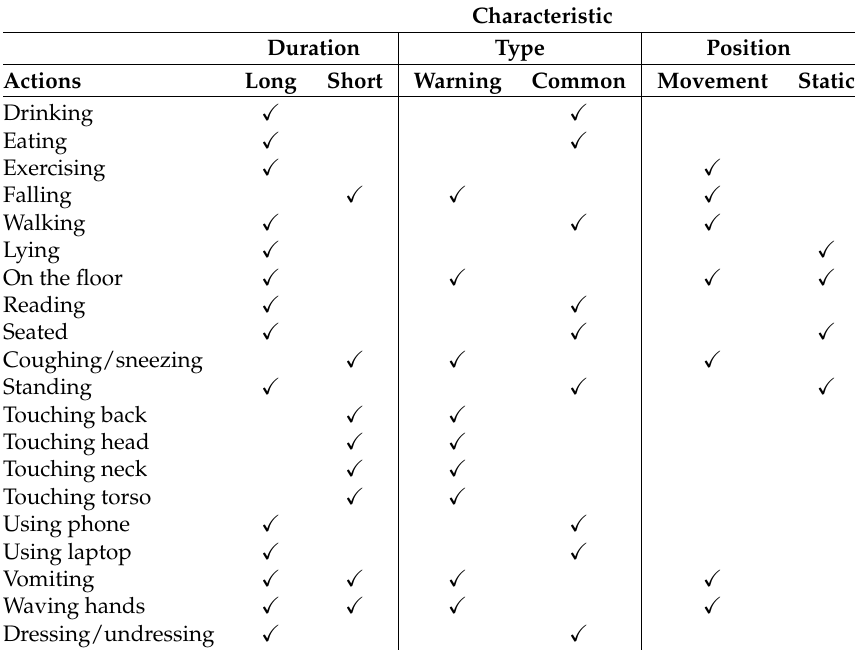
Table 3. Defined actions of interest, with the corresponding